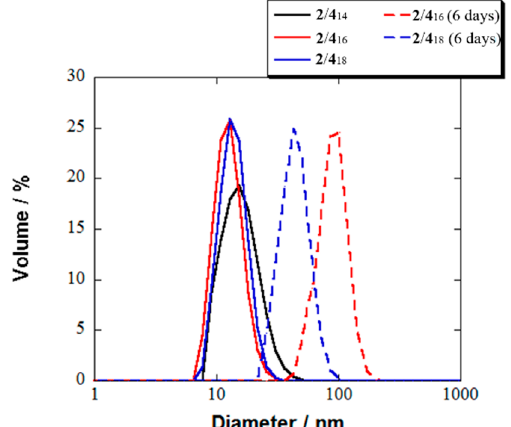
Figure 2. Mean diameters of mixed micelles 2 / 4 n ( n = 14, 16, and 18) determined by DLS at 25 ° C in PBS (black solid line: 2 / 4 14 just after preparation, red solid line: 2 / 4 16 just after preparation, blue solid line: 2 / 4 18 just after preparation, red dashed line: 2 / 4 16 after 6 days, blue dashed line: 2 / 4 18 after 6 days). See the Supplementary Information for experimental details.